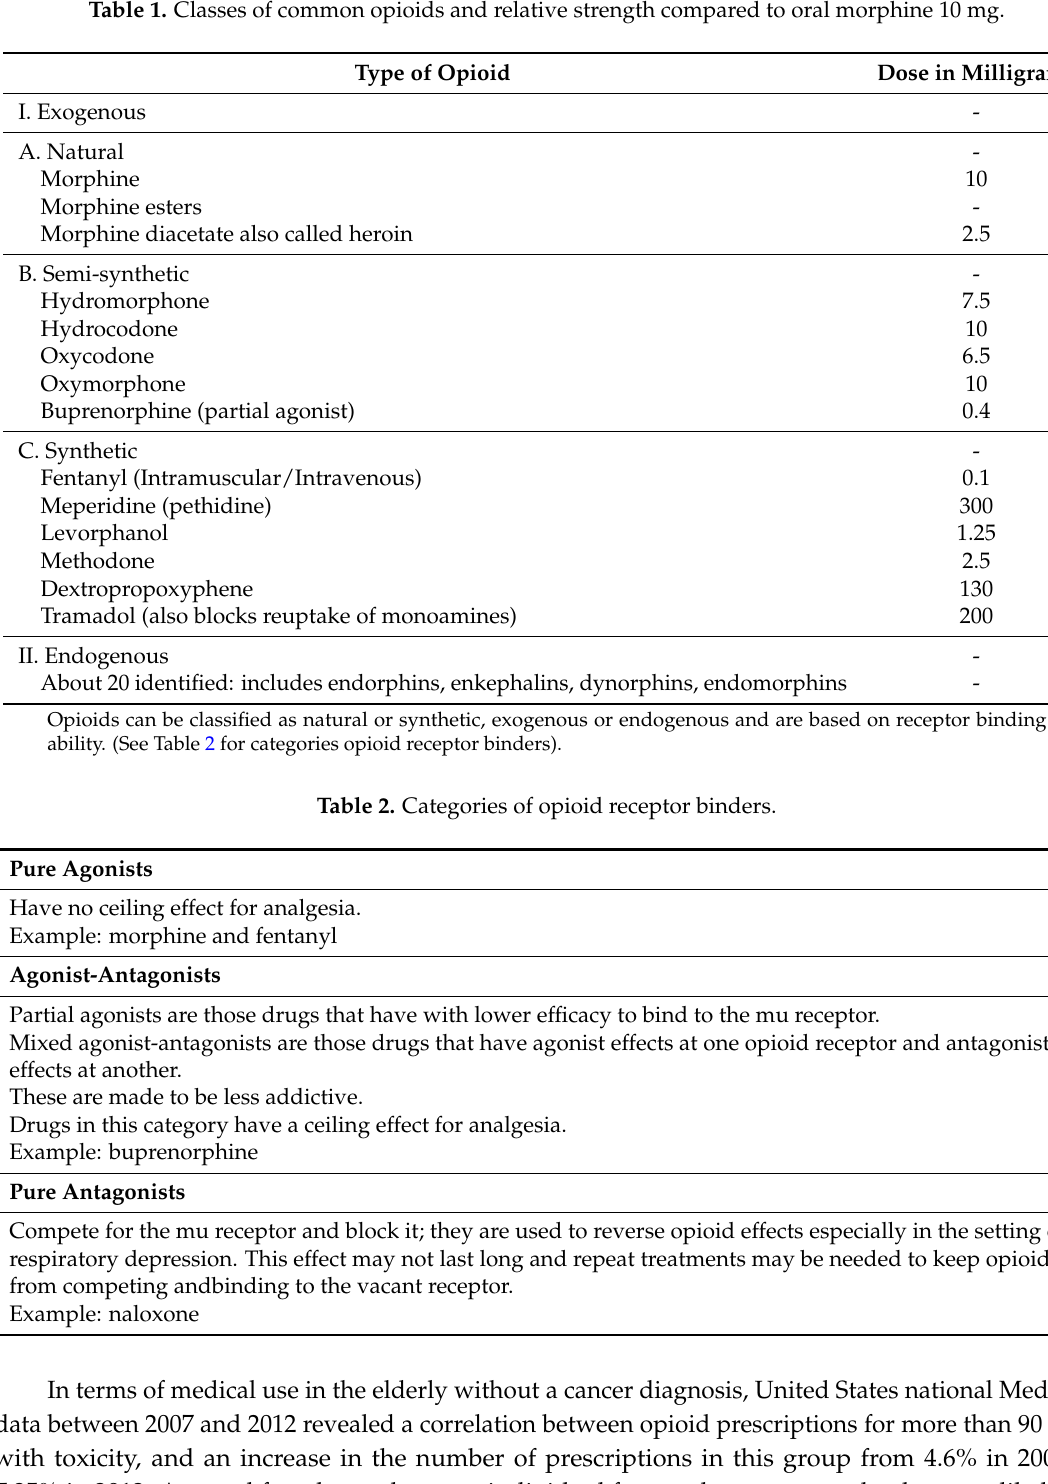
Table 1. Classes of common opioids and relative strength compared to oral morphine 10 mg.